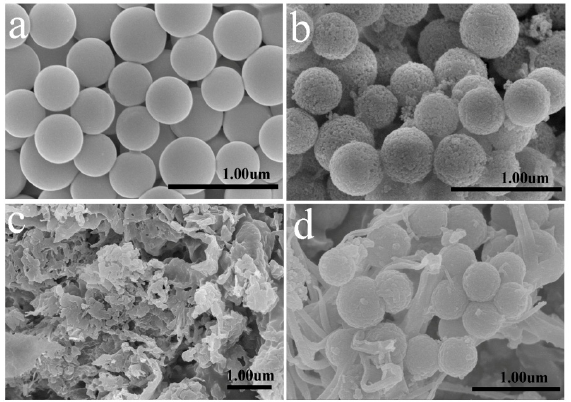
Figure 3. SEM images of ( a ) SiO 2 , ( b ) porous silicon sphere (Si), ( c ) PProDOT(MeSH) 2 , ( d ) PProDOT(MeSH) 2